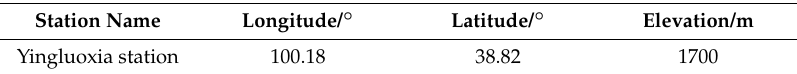
Table 3. Hydrological station